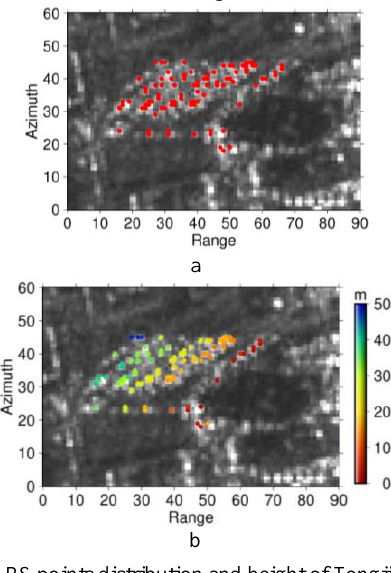
Figure 7. PS points distribution and height of Tongji Medical College Building (a. Distribution of PS points, b. Elevation of PS points